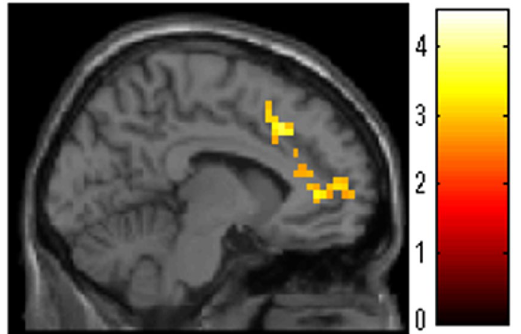
Figure 2. Larger increases in degrees of centrality (DC) were observed in the working memory training (WMT) group compared with the control group. Results are shown with a threshold of P < 0.05 and data were corrected for multiple comparisons at the cluster size with an underlying uncorrected voxel-level of P < 0.005. These data show that compared with no intervention (control), WMT significantly increased DC in the anatomical cluster that spread from the medial prefrontal cortex to ventral and dorsal anterior cingulate cortexes.